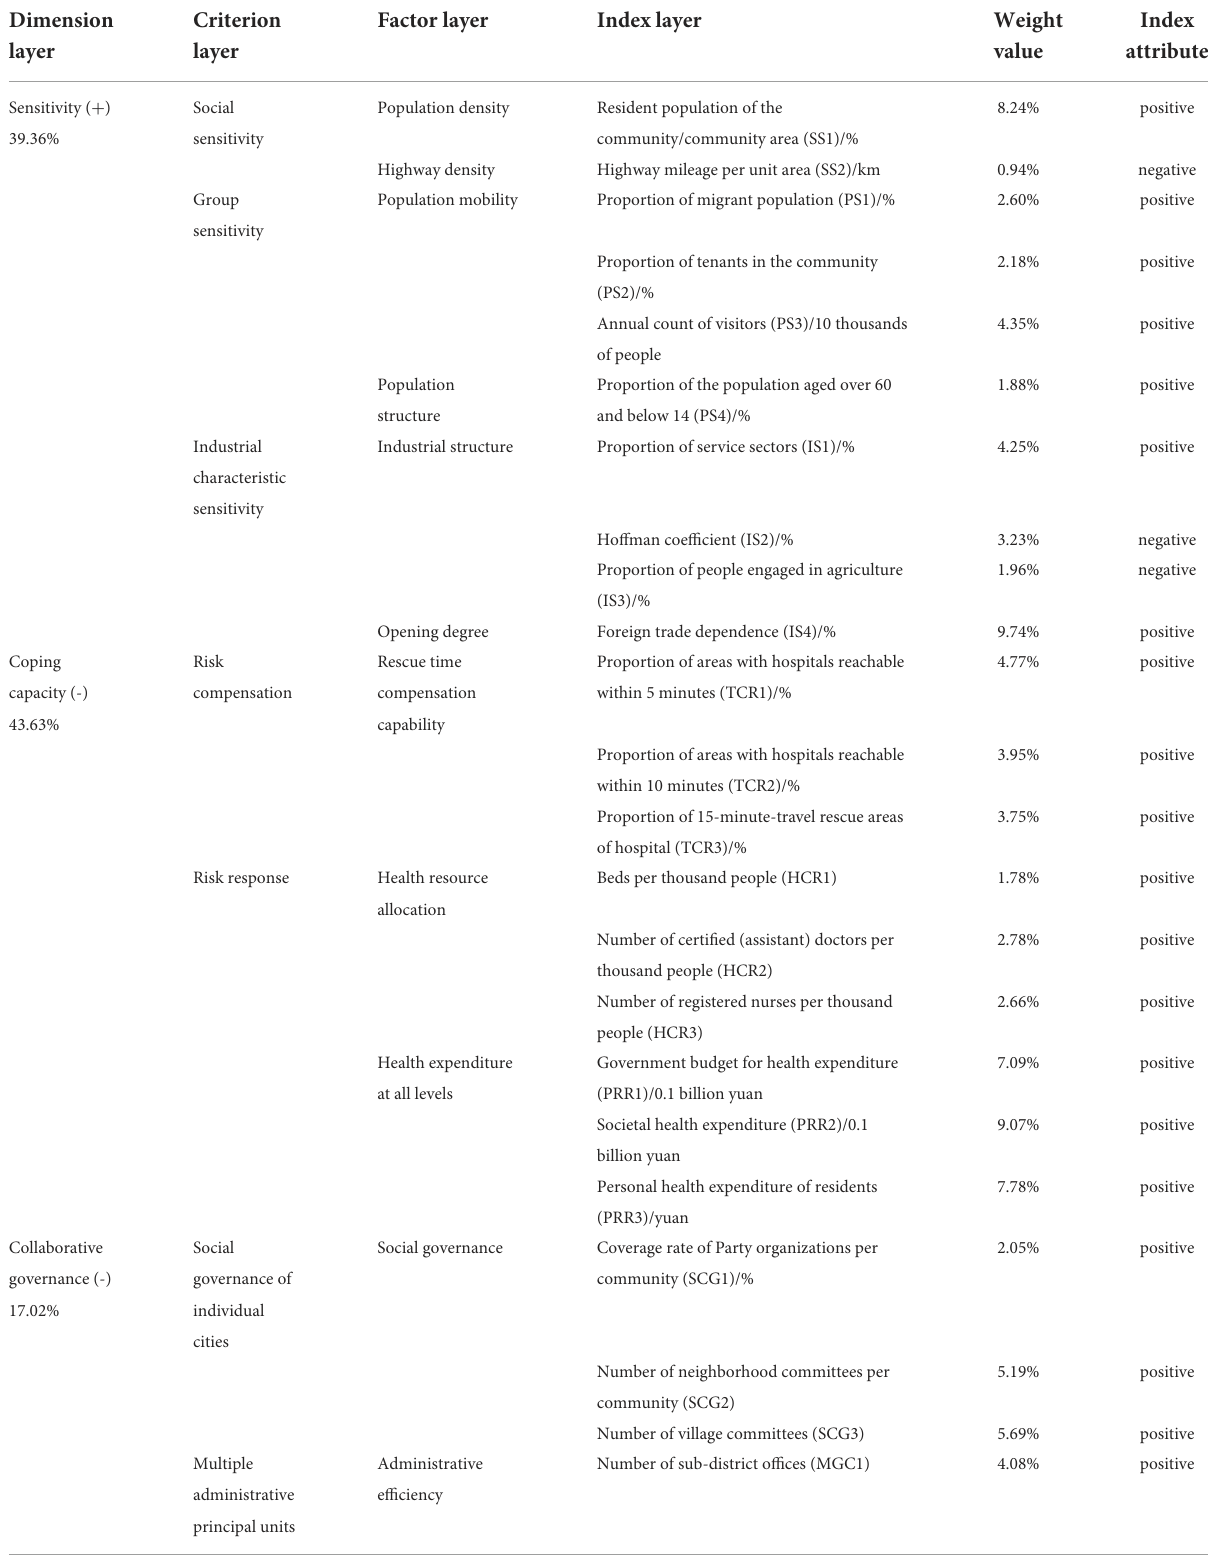
TABLE 1 Dynamic Evaluation index system of the PVUA in